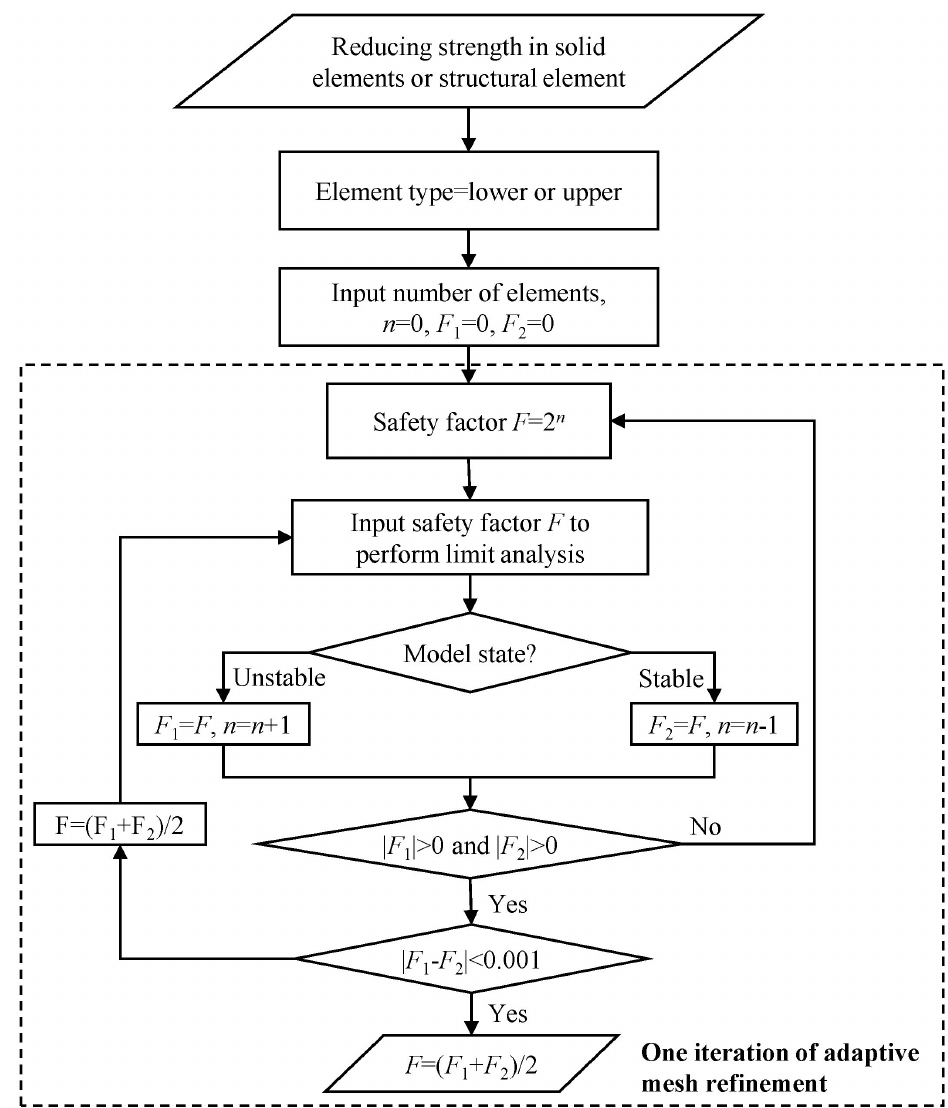
Figure 3. Flow diagram of the strength reduction